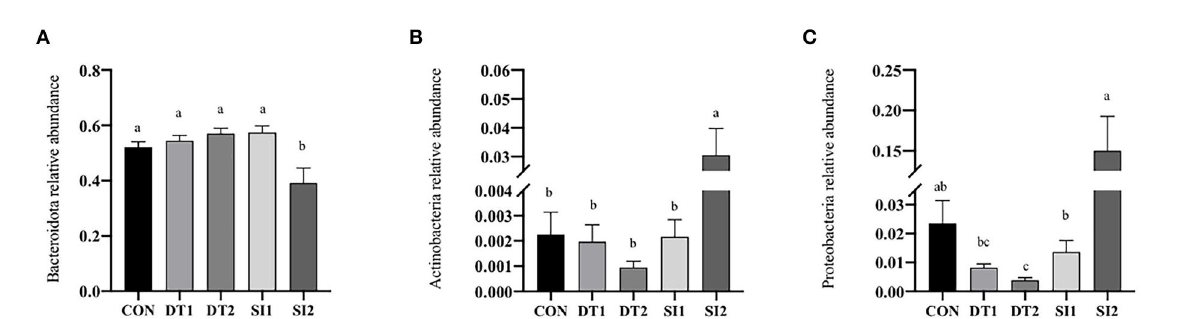
Blood biochemical indicators reflect the health status of the animal. Albumin is mainly produced by the liver, which indicates an improvement in protein synthesis at a higher level,